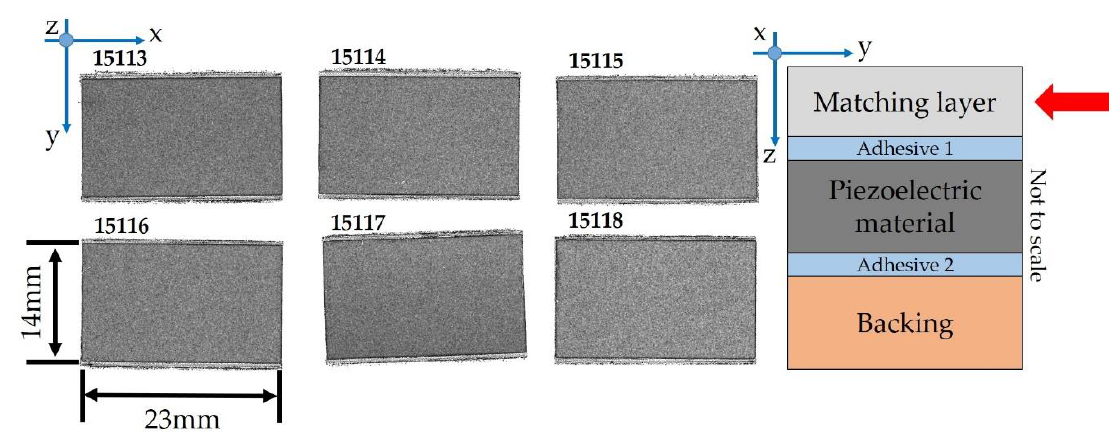
Figure 9. C-scan of the matching layer (lot #1). The surface area is around 322 mm 2 .